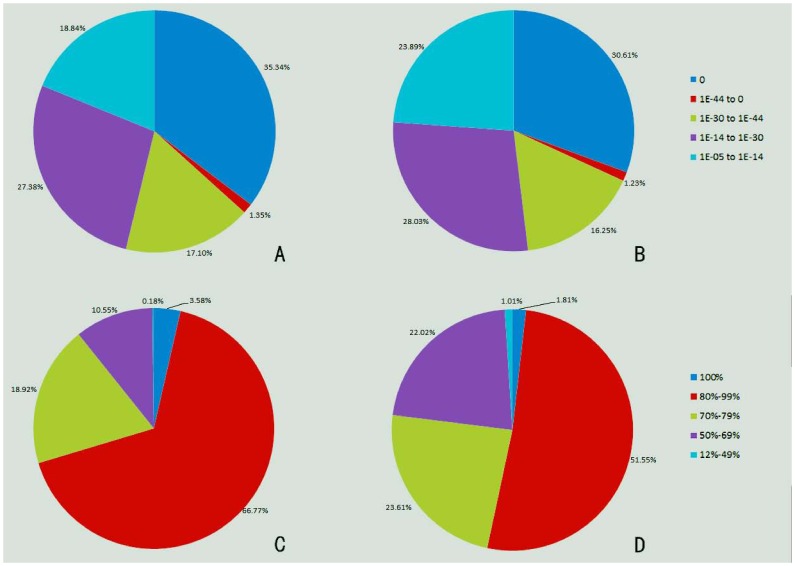
Characterization of the searched assembled unigenes against the nr and SwissProt protein databases.(A) E-value distribution of the BLAST hits for the assembled unigenes with a cutoff of 1e-5 in the Nr database. (B) E-value distribution of the BLAST hits for the assembled unigenes with a cutoff of 1e-5 in the SwissProt database. (C) Similarity distribution of the top BLAST hits for the assembled unigenes with a cutoff of 1e-5 in the nr database. (D) Similarity distribution of the top BLAST hits for the assembled unigenes with a cutoff of 1e-5 in the SwissProt database.